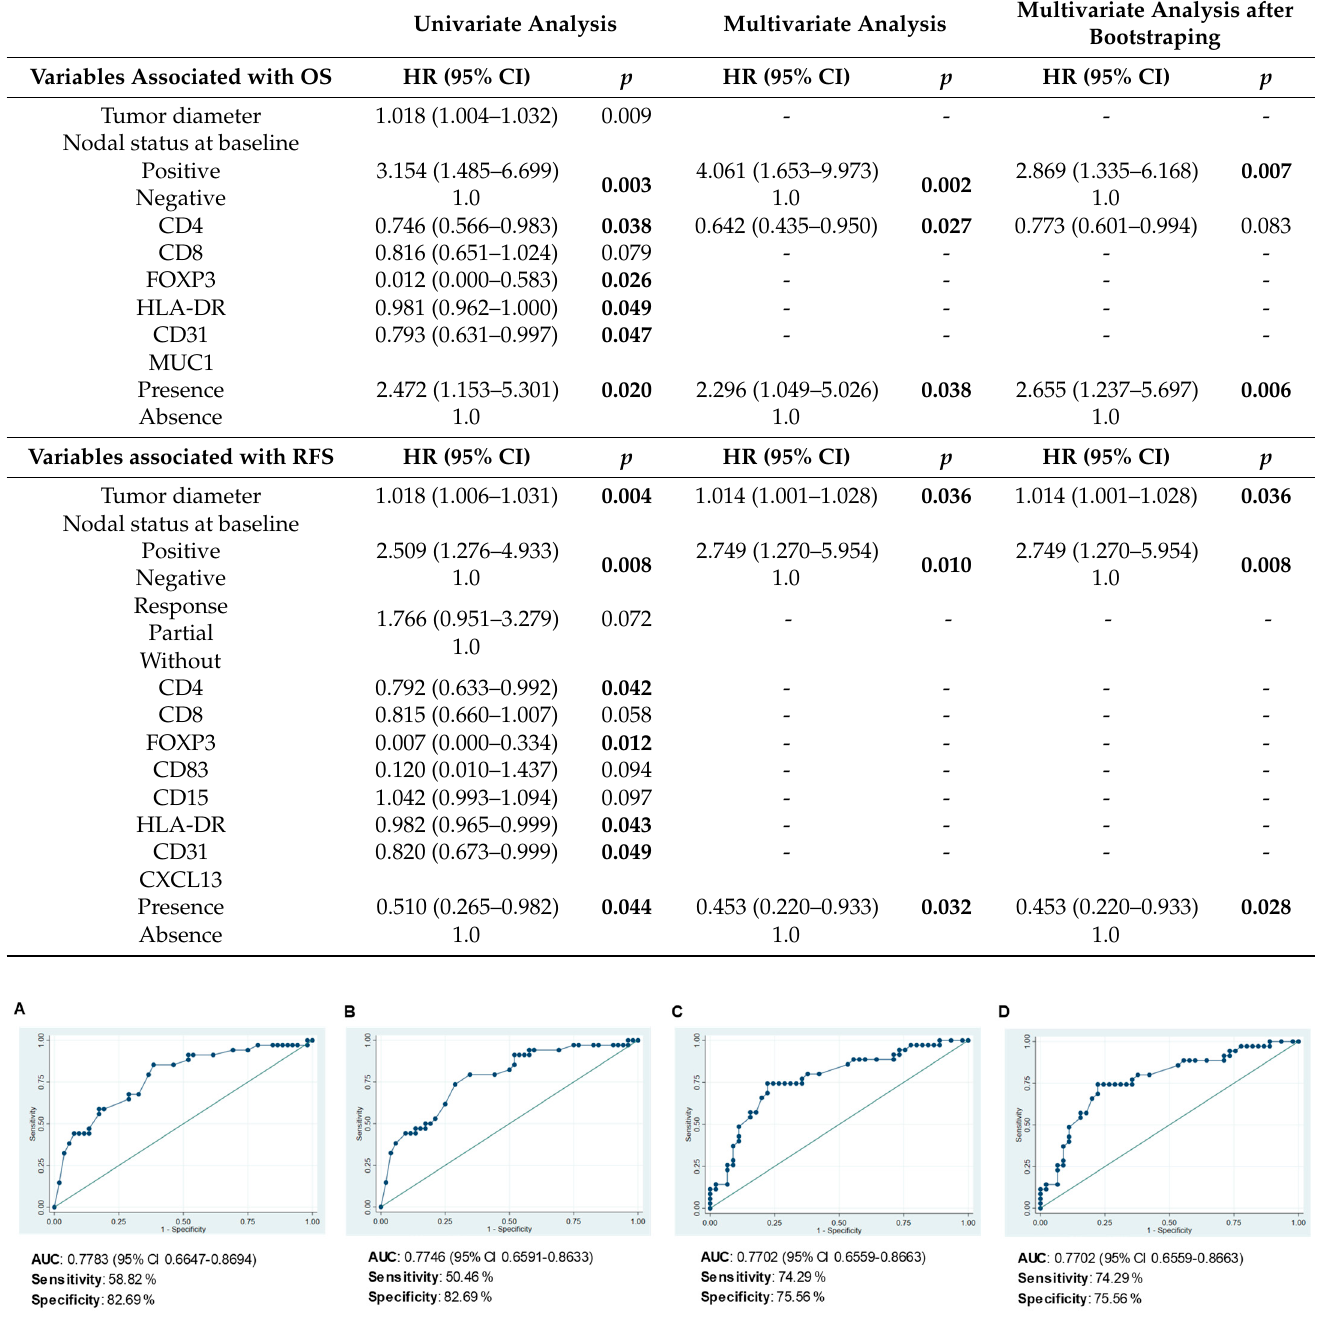
Table 3. Univariate and multivariate Cox analyses of markers and clinico-pathological variables associated with survival and relapse during the five-year follow-up in TNBC patients. Univariate Analysis Multivariate Analysis